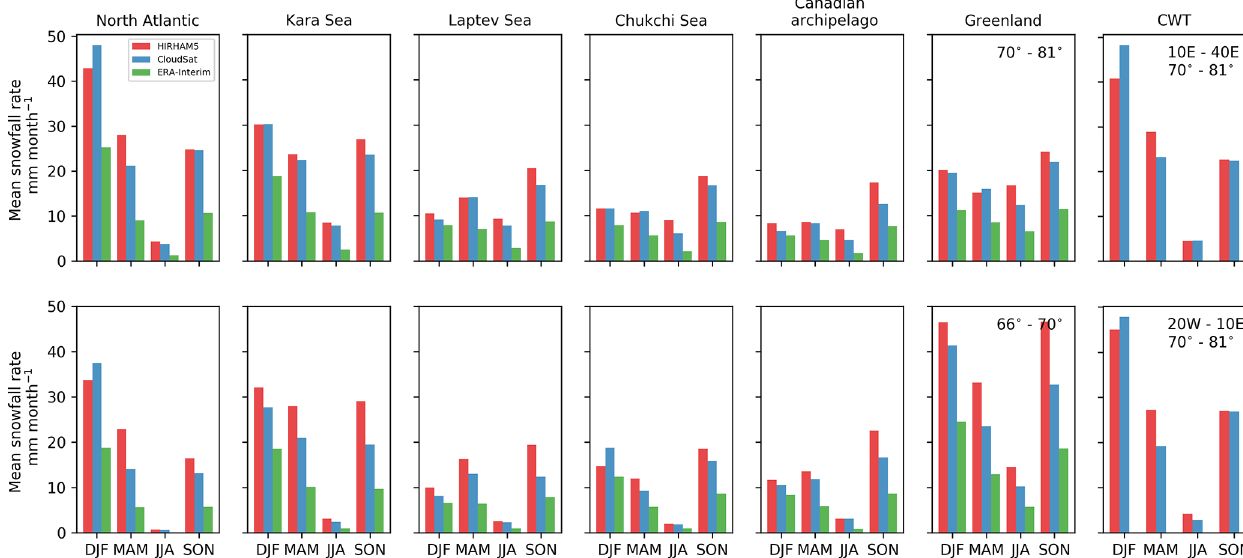
Figure 5. Monthly area-weighted mean snowfall rates of HIRHAM5, CloudSat and ERA-Interim shown seasonally for each studied region. The latitude band 70–81 ◦ N is shown in the upper and the band 66–70 ◦ N in the lower panel. In the rightmost column, monthly area-weighted mean snowfall rates of HIRHAM5 and CloudSat are shown for both North Atlantic CWT